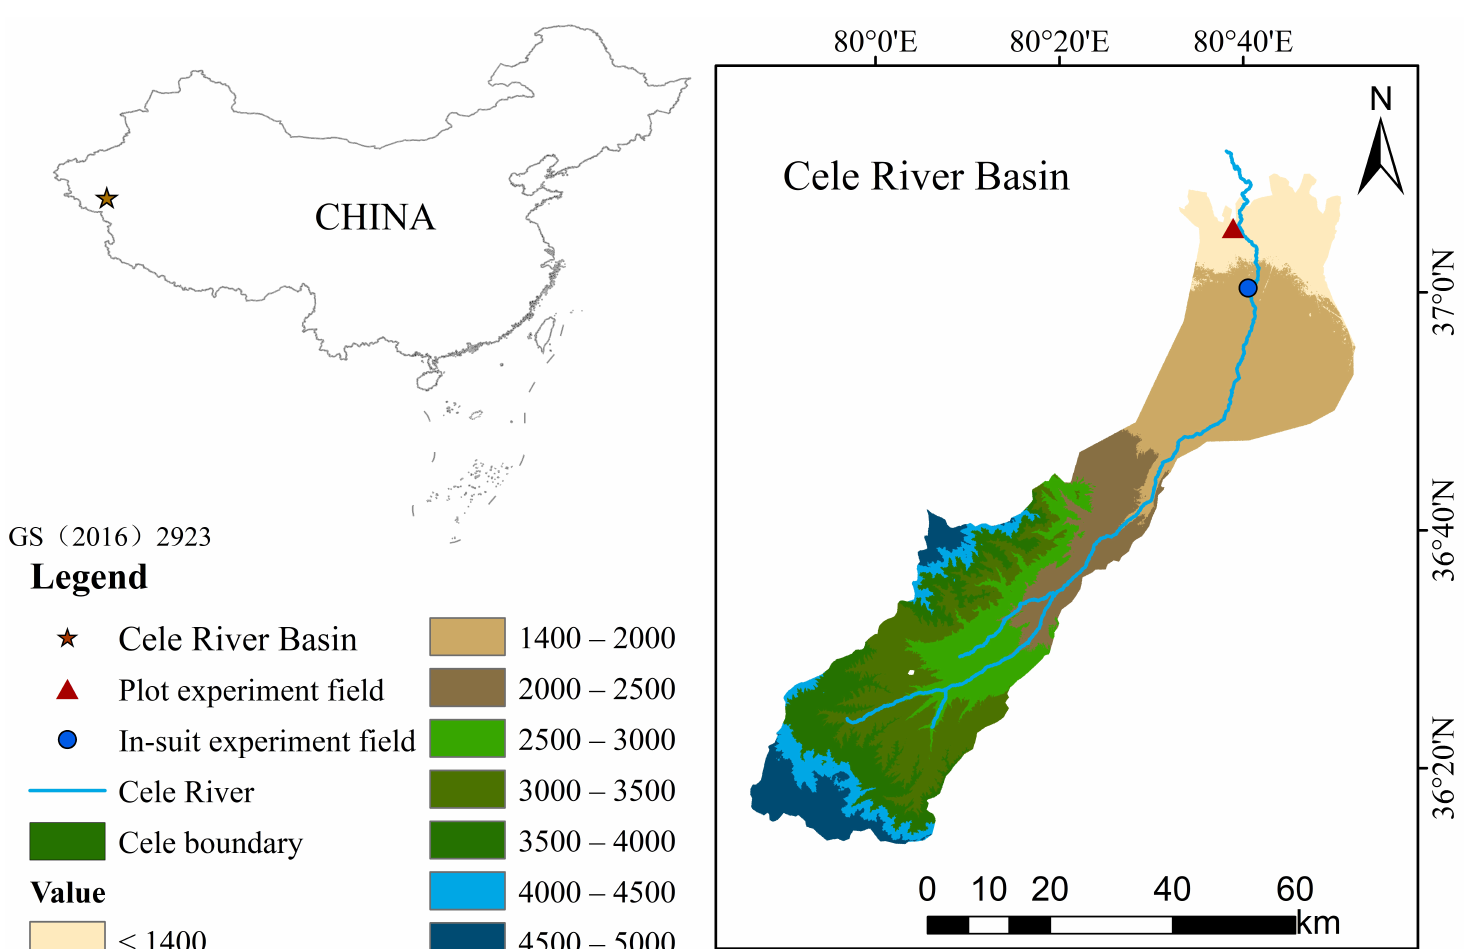
Figure 1. Location of the study